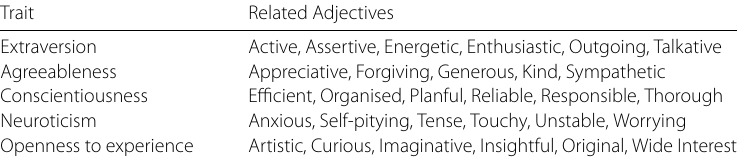
Table 8 The Big-five traits and examples of adjectives describing them [84]